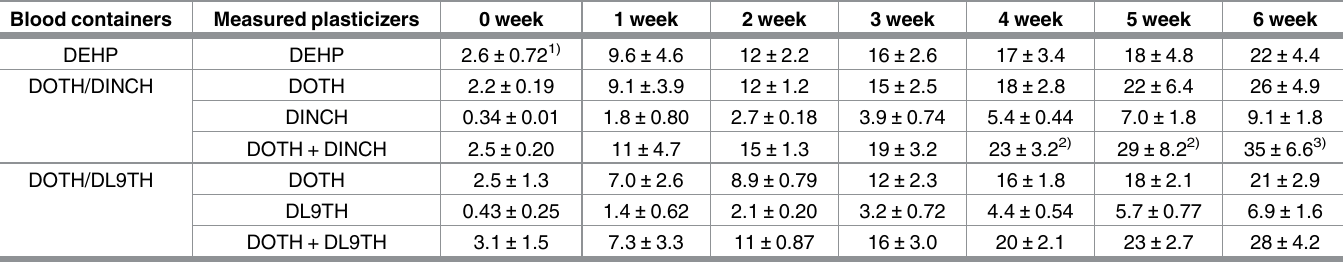
Table 1. Amount of plasticizer eluted from blood containers into MAP/RCC ( μ g/mL). Blood containers Measured